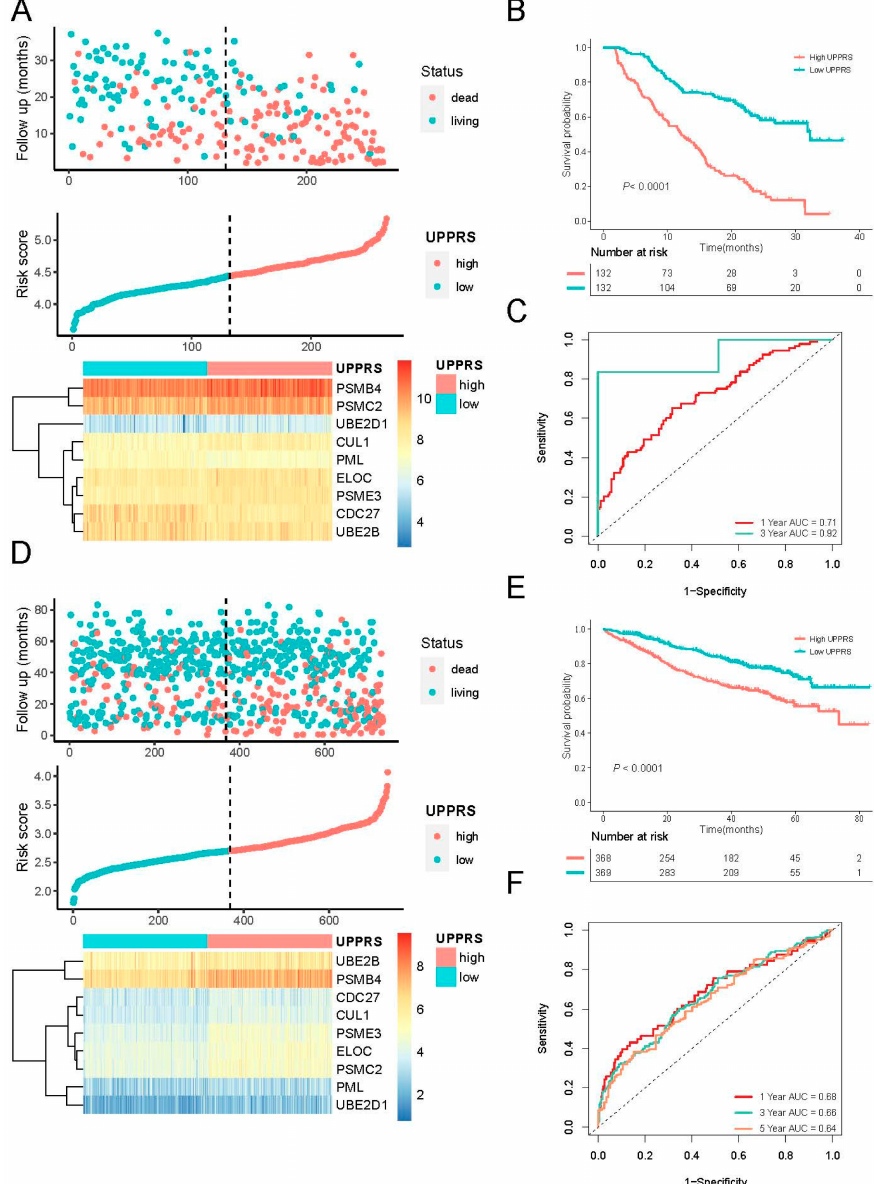
Figure 2. Construction of the UPPRS in the training and validation cohort. ( A ) Survival status, distribution of UPPRS, and expression of the UPPGs in the training cohort. ( B ) Survival curves